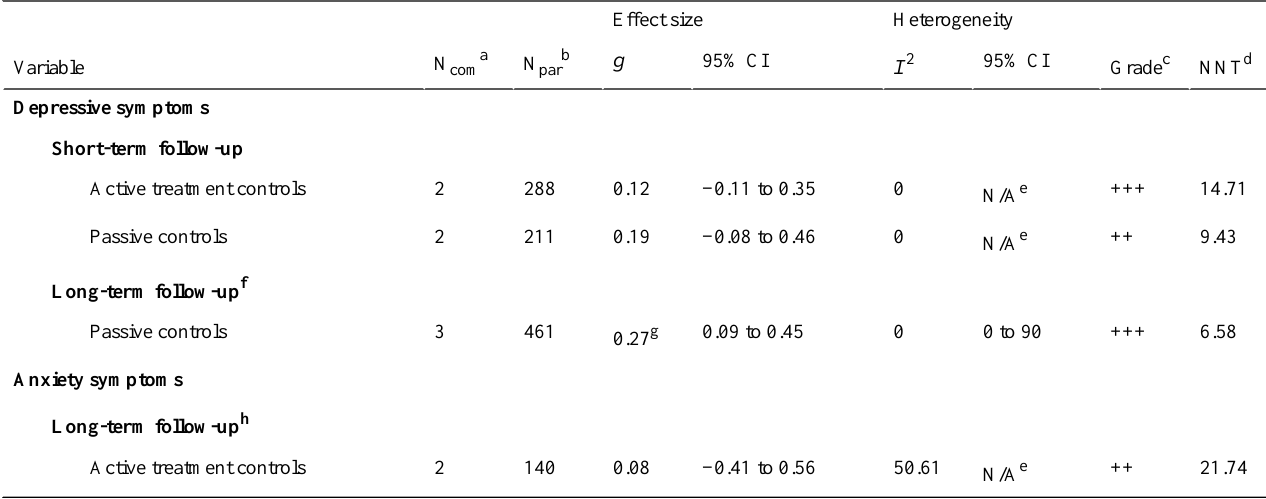
Table 7. Effect sizes regarding depressive and anxiety symptoms in the meta-analysis of studies comparing computerized cognitive behavior therapy in adolescents and young adults with active treatment and passive controls at short-term follow-up (1-5 months) and long-term follow-up (6-12